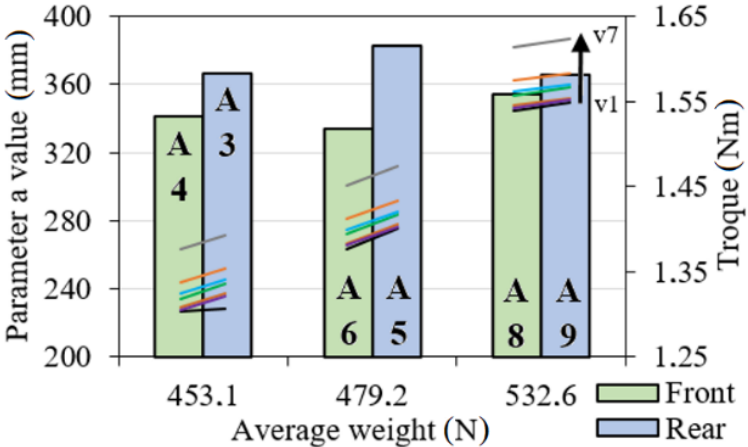
Figure 12. Increase in torque demand in relation to parameter 𝑎 value for the “Front” and “Rear” configurations with the averaged weights of the experiment variants; straight coloured lines represent the torque values for the different simulated wheelchair velocities.